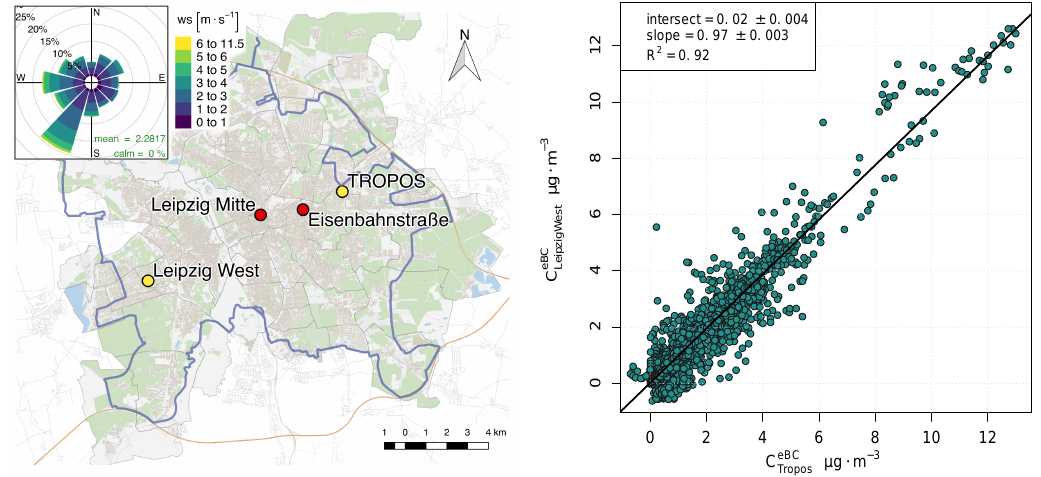
Figure 2. Left: Location of the measurement stations within the city (red: roadside station; yellow: urban background station). Additionally, the border of the low emission zone (LEZ) is included as blue line. The wind rose shows the wind speed (color scale) as frequency according to wind direction. Right: Correlation of the measured eBC concentration C eBC for the urban background stations TROPOS and Leipzig